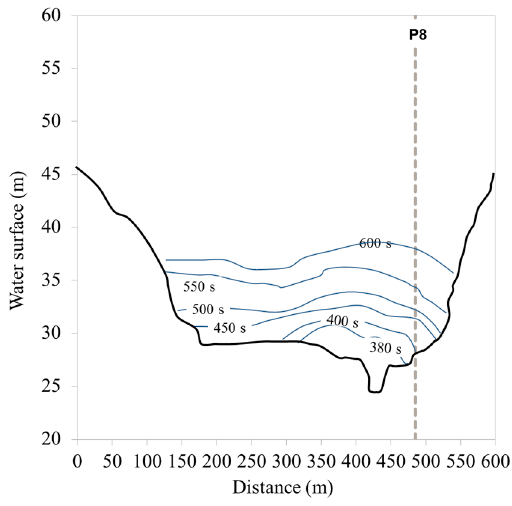
Figure 8. Evolution of the free surface over time in the cross section containing the point P8. Table 5. Geometric characteristics for points P i and G i : curvature radius (R), top width channel (B), height (H) and corresponding morphodynamic ratios R/B, B/H and R/H.